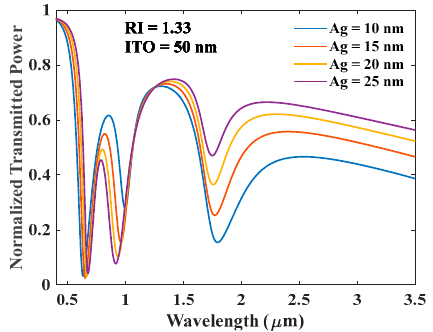
both ITO layers are 50 nm thick.